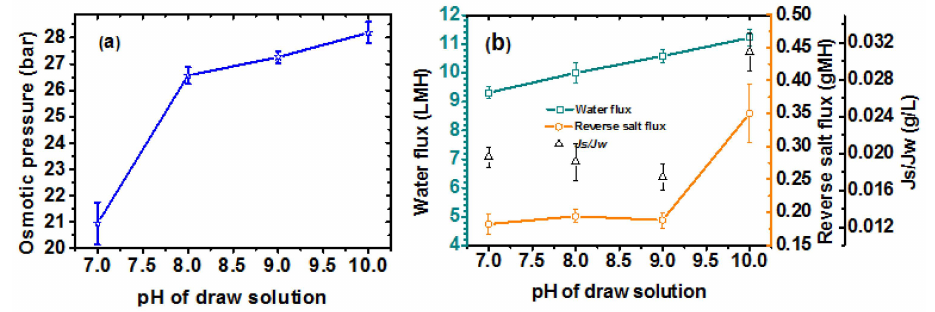
Figure 3. The effect of draw solution pH on ( a ) the osmotic pressure; ( b ) the forward osmosis (FO) performance. (0.1 g/mL STPH solution as the draw solution, the active layer of FO membrane facing the feed solution: PRO